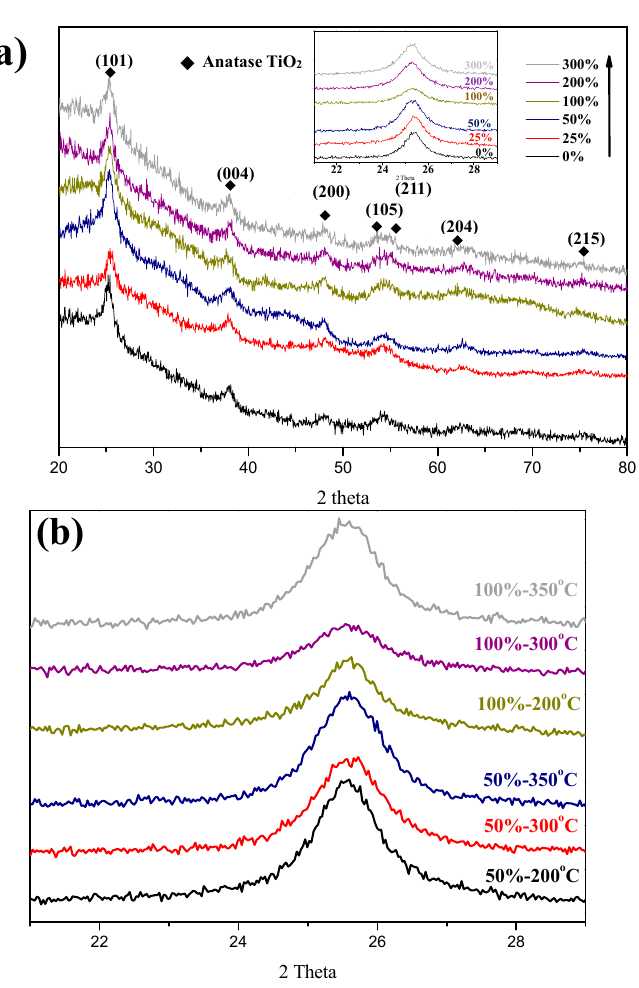
Figure 4. ( a ) X-ray diffraction patterns of C–TiO 2 synthesized from different glucose concentrations after sintered at 300 °C (Inserted: XRD signals of C–TiO 2 films moved to Si substrates between 20° to 30°). ( b ) Partial XRD spectra of 50% and 100% C–TiO 2 after baked at temperatures ranging from 200 to 350 °C.